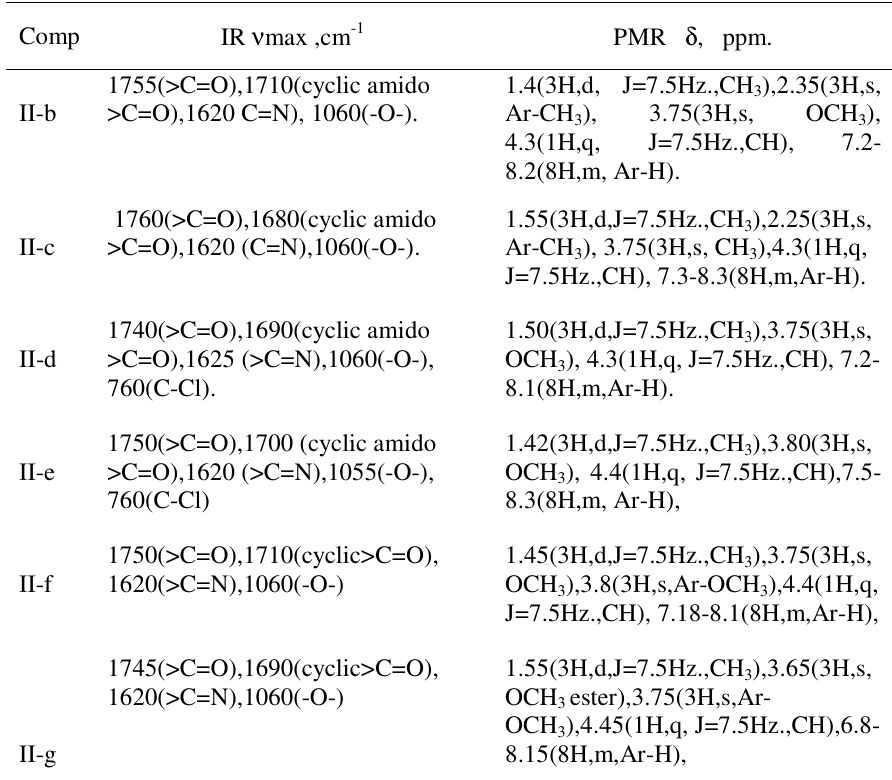
Table 2. Spectral characteristics of the compounds [II-(b-g)]